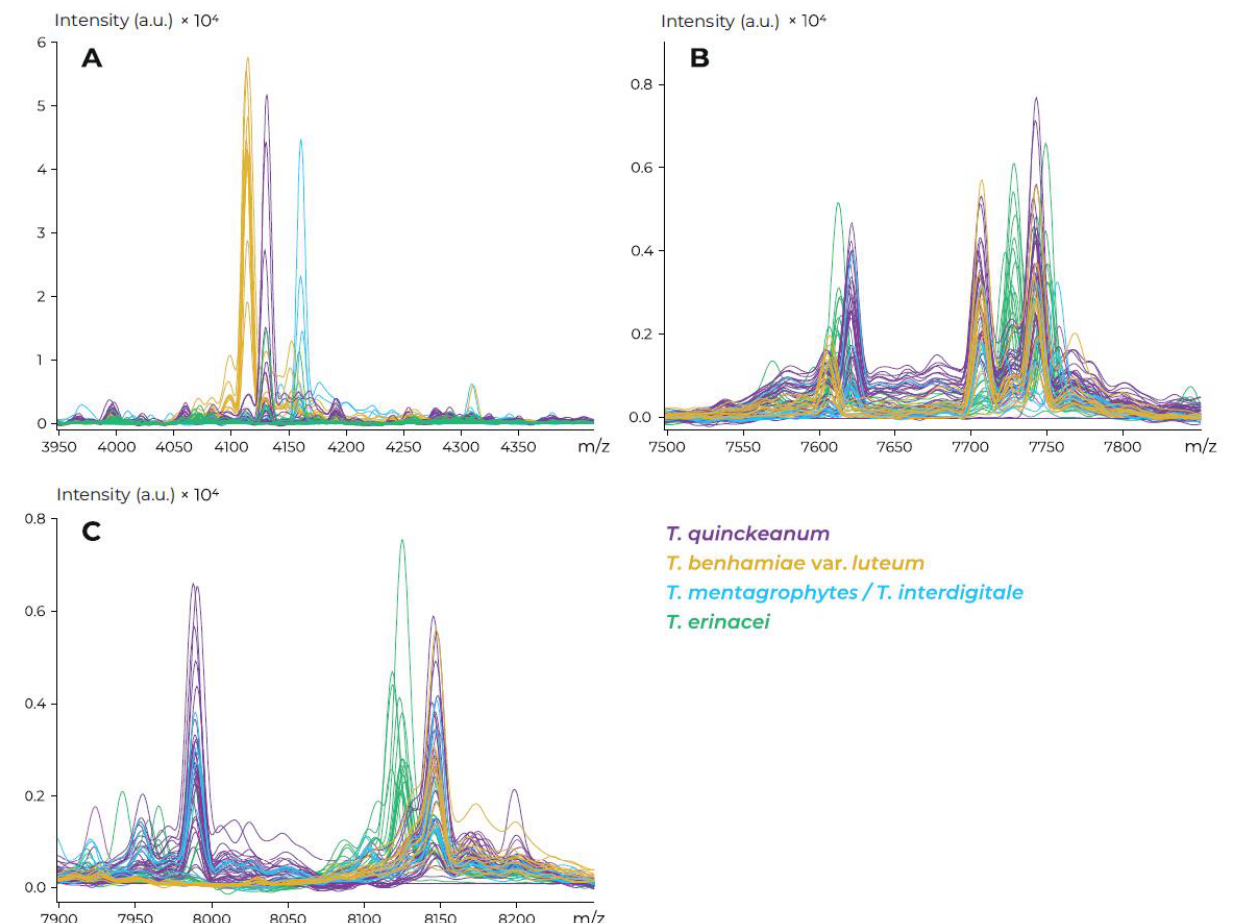
Figure 4. Comparison of mass spectra of Trichophyton quinckeanum with common zoophilic Trichophyton species, ( A ): 4050–4200; ( B ): 7500–7850; ( C ): 7950–8250. Table 4. Antifungal susceptibility of 36 Trichophyton quinckeanum strains by EUCAST reference method E.Def 11.0. Antifungal